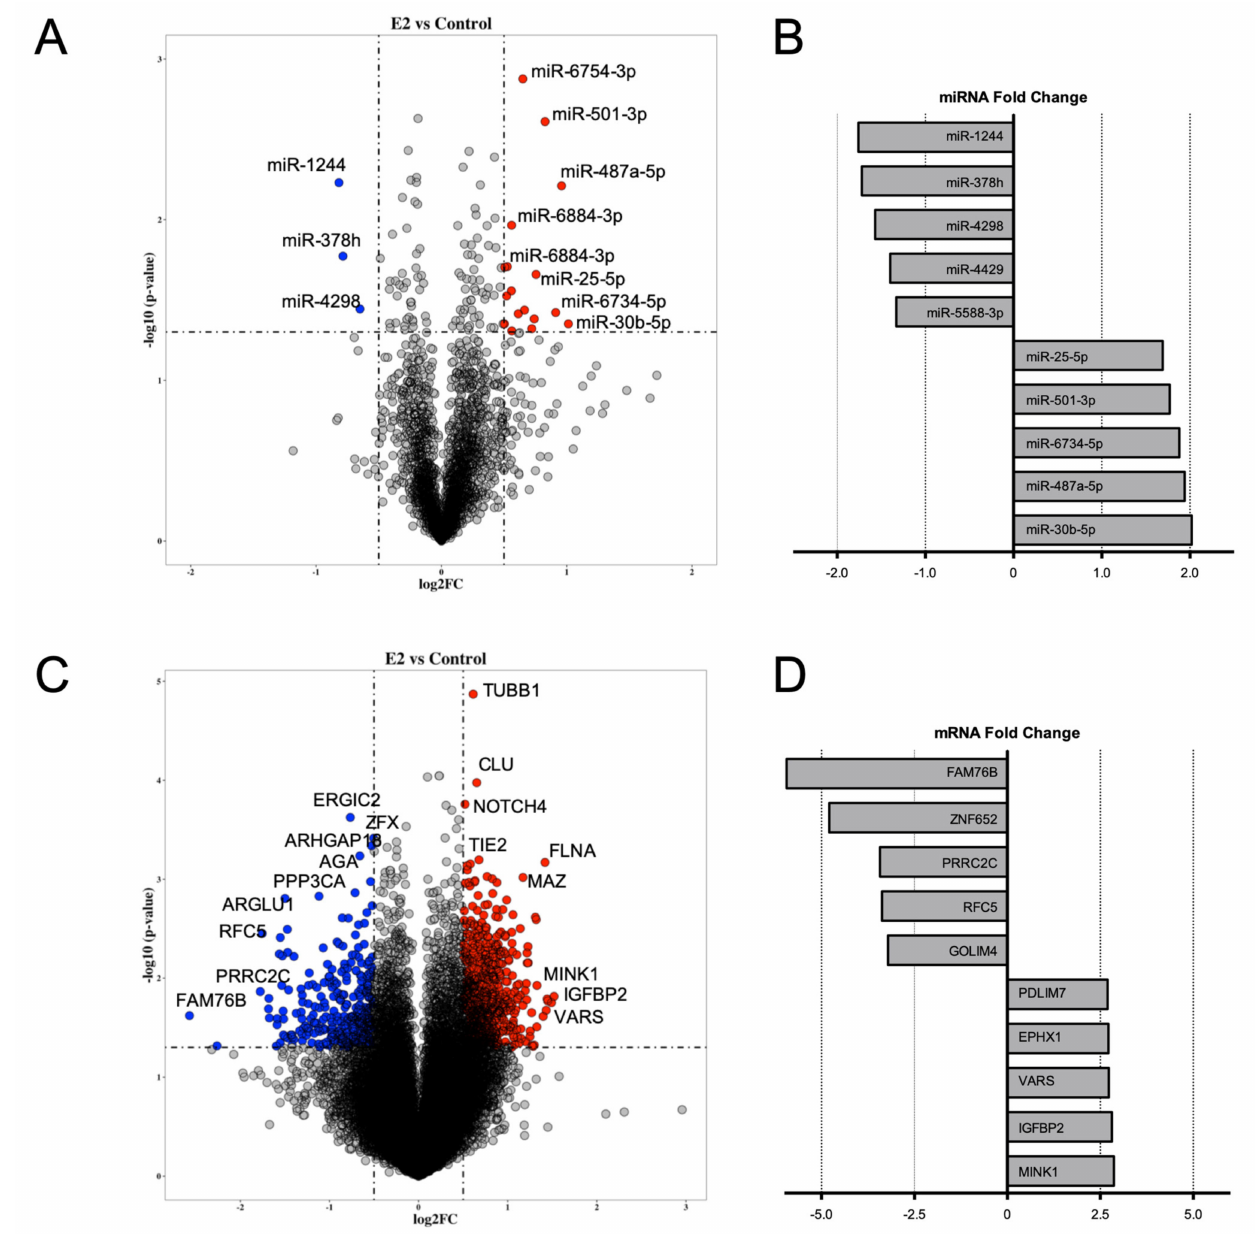
Figure 1. Distribution of differentially expressed miRNAs and mRNAs obtained using microarray of estradiol–exposed HUVEC. HUVEC were treated with vehicle (0.1% ethanol) or estradiol (1 nmol/L) for 24 h and non-coding RNA were determined using microarray technology. Volcano plot highlighting differentially expressed miRNAs ( A ) and mRNAs ( C ) between E2-treated and control samples ( p value < 0.05 and log2 fold change > 0.5). Upregulated hits on upper right quadrant (red dots) and downregulated hits on upper left quadrant (blue dots). ( B ) Top five up- and downregulated miRNAs ( B ) and mRNAs ( D ) are shown based on fold